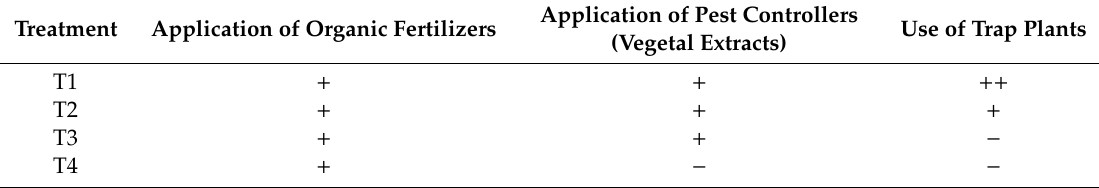
Table 1. Treatments established for the organically grown ‘Maradol’ papaya. Application of Pest Controllers Treatment Application of Organic Fertilizers Use of Trap (Vegetal Extracts)